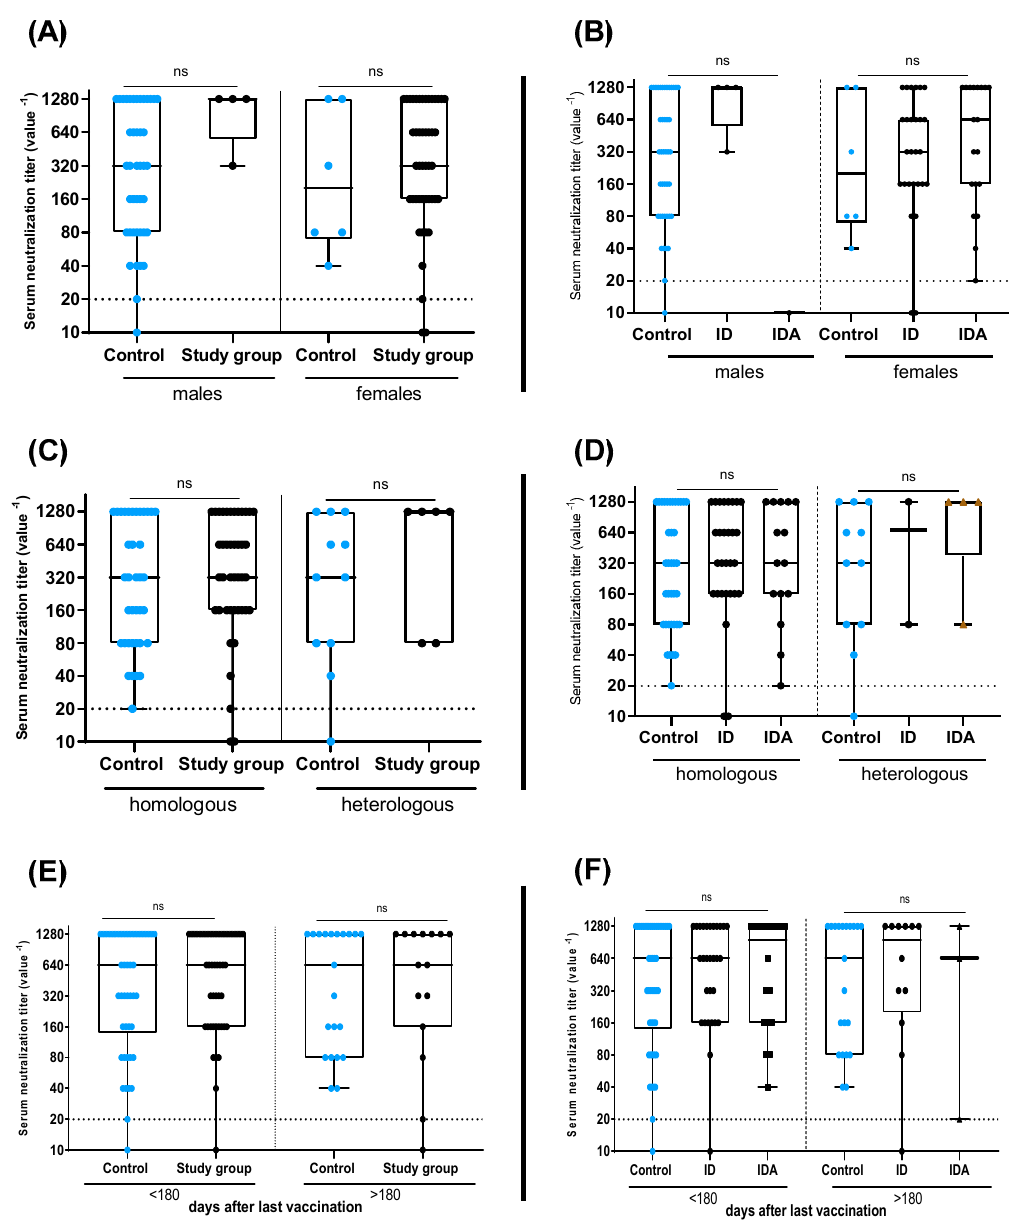
Figure 5. The effect of different variables on the neutralization titer among control group (normal hemoglobin and ferritin) and study group (right panel: ID and IDA combined; left panel: ID and IDA separated). Neutralizing antibody titers related to gender ( A , B ), type of vaccine received ( C , D ), and period since vaccination ( E , F ). Boxes represents 25th to 75th percentile range, black line demon- strate the median, and whiskers show minimum and maximum values. Mann–Whitney U test and Kruskal–Wallis test were used as required. ns indicates non-significant.